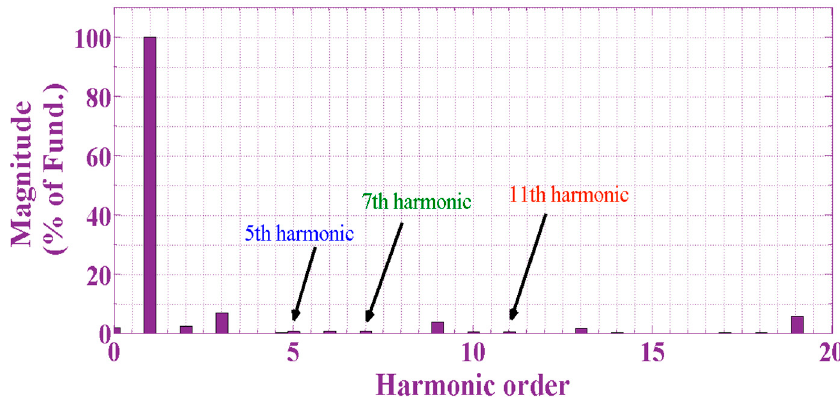
Figure 12. Harmonic spectrum of the voltage across phase A.